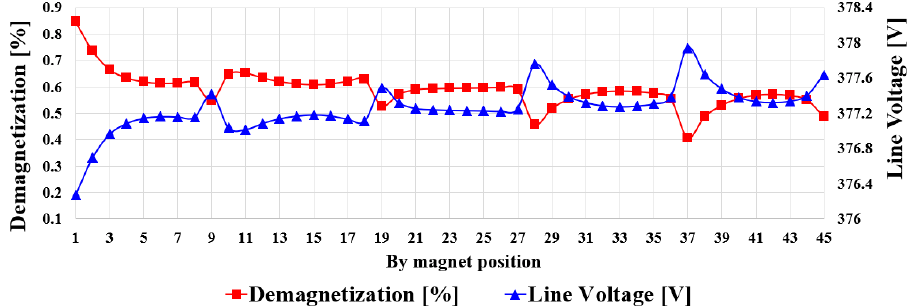
Figure 10. Demagnetization ratio according to each part of the magnet.